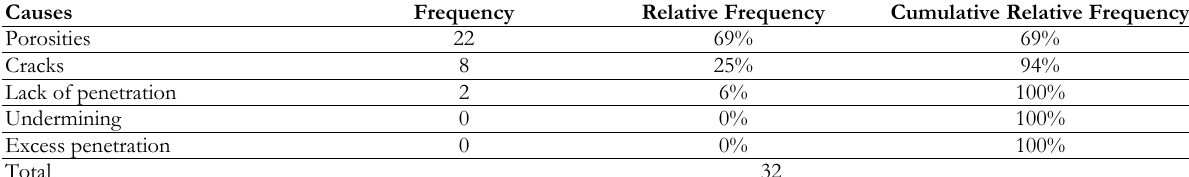
Table 3. Improvement